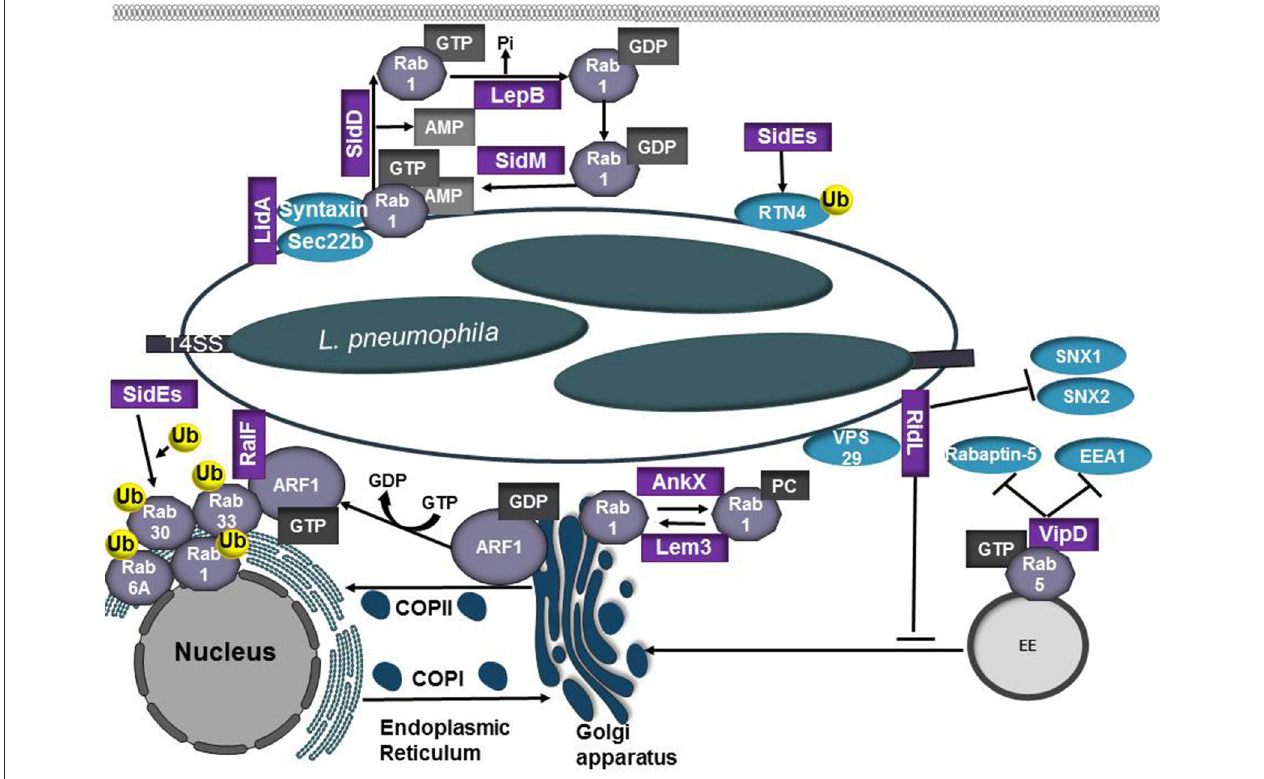
FIGURE 5 | Role of L. pneumophilia T4SS effector proteins in modulation of the endocytic and secretory pathways. L. pneumophila recruits the small GTPases Rab1 and Arf1 to the LCV membrane to co-opt ER-Golgi vesicle trafficking. RalF and SidM/DrrA are Arf1 and Rab1 GEFs, respectively. SidM/DrrA can covalently modify Rab1 through AMPylation whereas SidD functions as a deAMPylase to remove the AMP residue, making Rab1 susceptible to inactivation by the bacterial GAP LepB. Activated Rab1 promotes binding of LidA, which cooperates with SidM/DrrA to promote tethering and fusion between the LCV and ER-derived vesicles. AnkX and Lem3 modify Rab1 activity through phosphorylcholination (PCylation) or by removal of the phosphorylcholine moiety, respectively. The SidE family of T4SS effectors (SidE, SdeA, SdeB, SdeC) ubiquitinate Rab1, Rab6, Rab30, and Rab33b. SidE effectors also ubiquitinate reticulon 4 (RTN4) to induce ER rearrangements